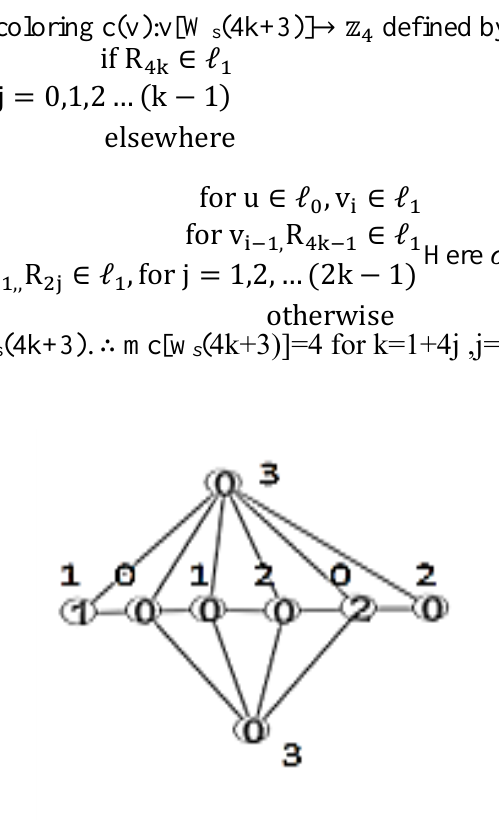
Figure1 . Switching with modular coloring in